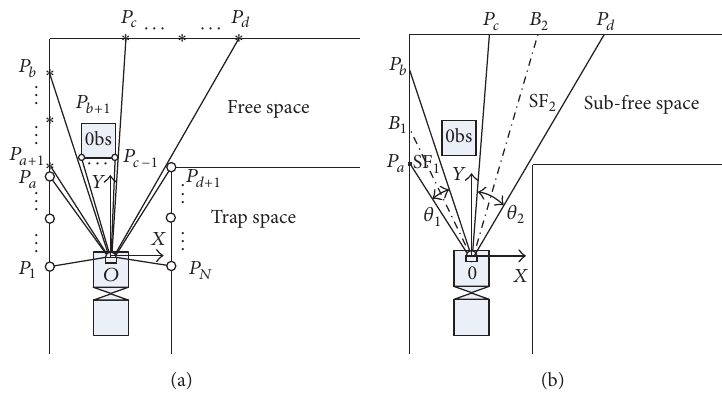
Figure 3: Free space and trap space (𝑎,𝑏, 𝑐, 𝑑 ∈ 𝑍, 2 < 𝑎 < 𝑏 < 𝑐 < 𝑑 < 𝑁) .